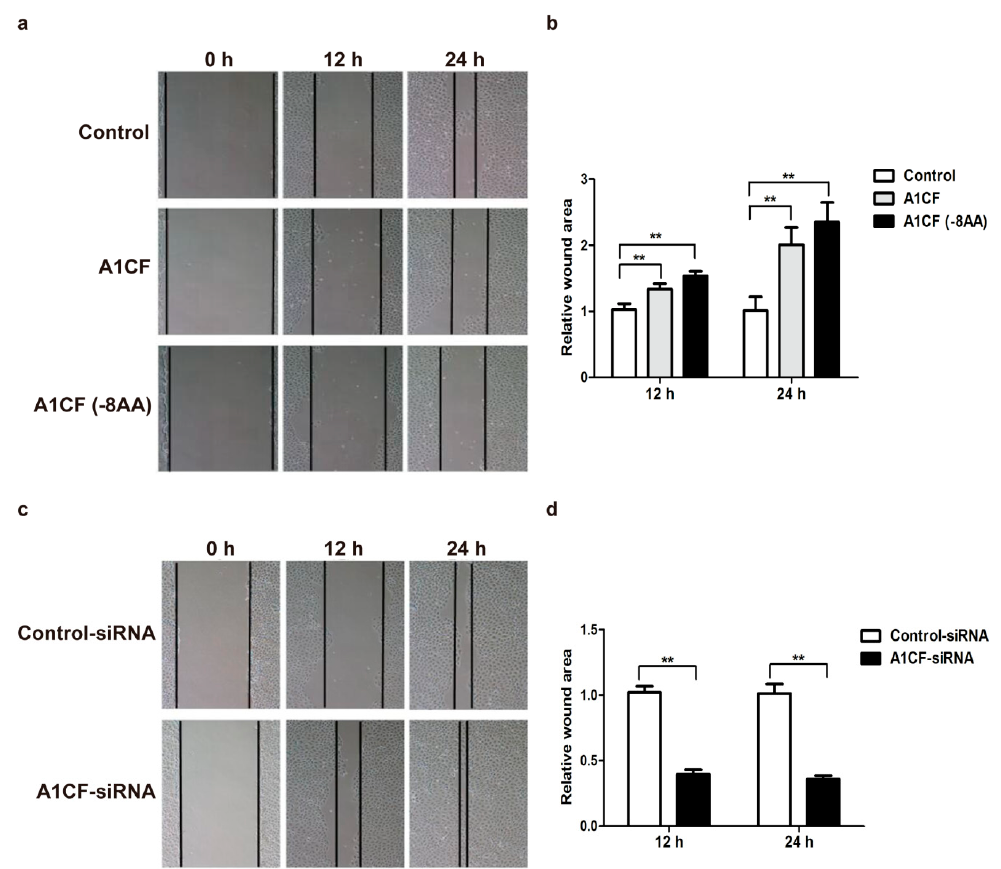
Figure 5. A1CF inhibits NRK52e cells migration. ( a ) Both A1CF and A1CF (-8AA) significantly inhibited NRK52e cells migration. Data were collected at 12 and 24 h (original magnification, ×100); ( c ) A1CF knockdown significantly increases NRK52e cells migration. Data were collected at 12 and 24 h (original magnification, ×100); ( b , d ) Data are presented as mean ± S.E.M. of three independent experiments. Statistical analysis was performed using Student’s t -test. ** p < 0.01 indicated significantly statistical differences compared with control groups.